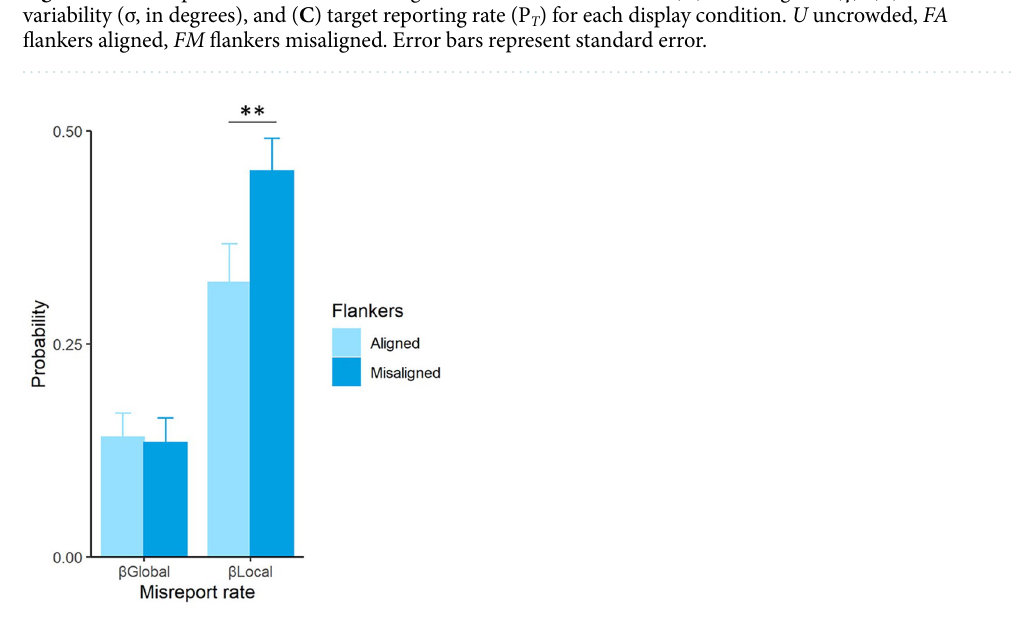
Figure 4. Probability of misreporting the global shape orientation (β global ) or a local flanker orientation (β local ) as the target for flankers aligned and flankers misaligned